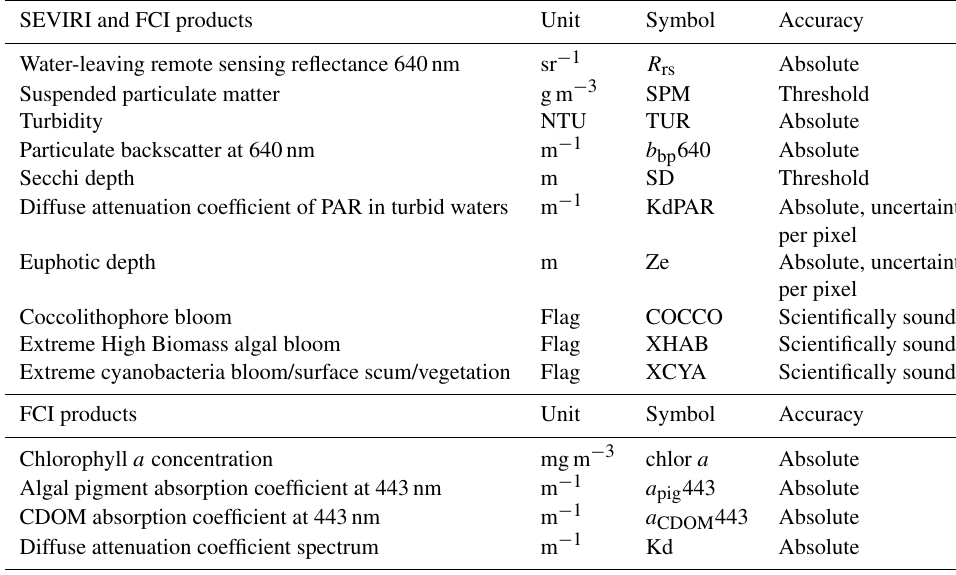
Table 4. Listing of SEVIRI and FCI ocean colour products requested by users. SEVIRI and FCI products Unit